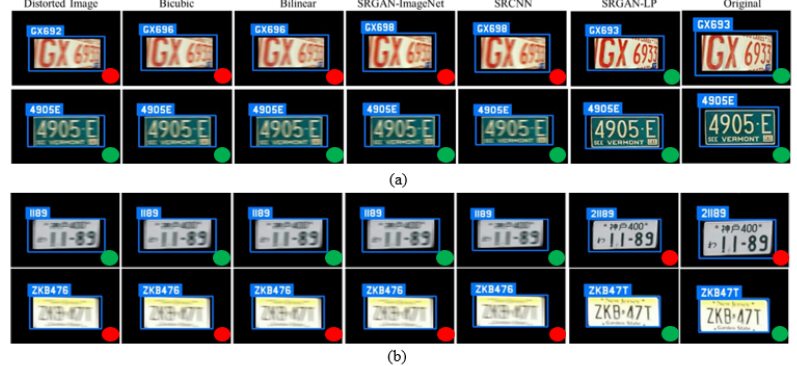
Figure 8. ( a ) Illustrates the visual results of OCR for the real test set, whereas ( b ) visualizes the results for the synthetic test set. Similarly, the green and red dots indicate the correct and incorrect predictions respectively.